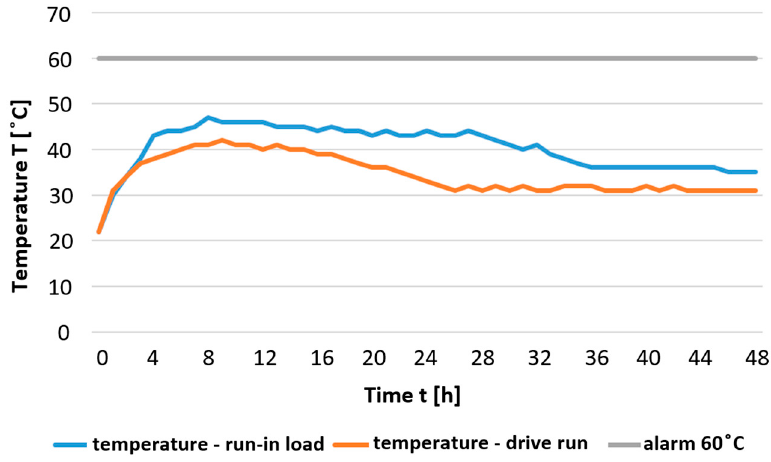
Figure 20. Course of temperatures on the BR TS 050 support body over a 48 h mode.